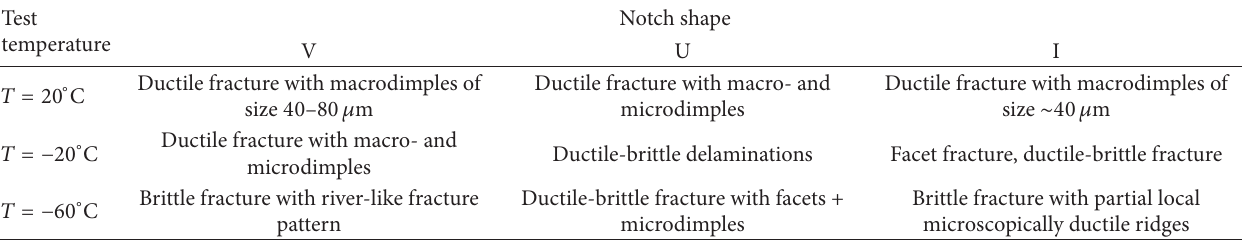
Table 5: Fracture micromechanisms in the crack initiation zone for specimens with different-shaped concentrators.